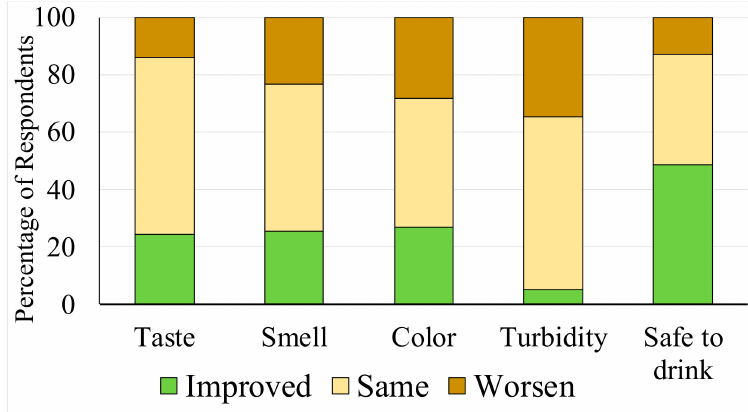
Figure 5. Direction of change in drinking water quality perception among LCD